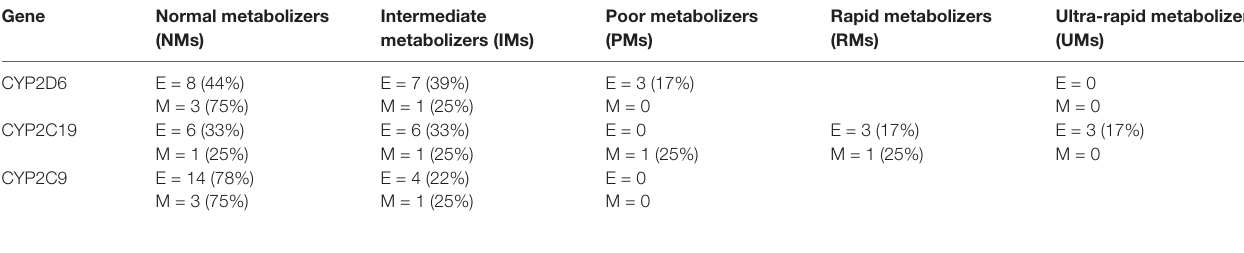
TABLE 2 | Predicted phenotype summary for 22 study participants, broken down by ethnicity (E = European (n = 18), M = M ā ori (n = 4)). Gene